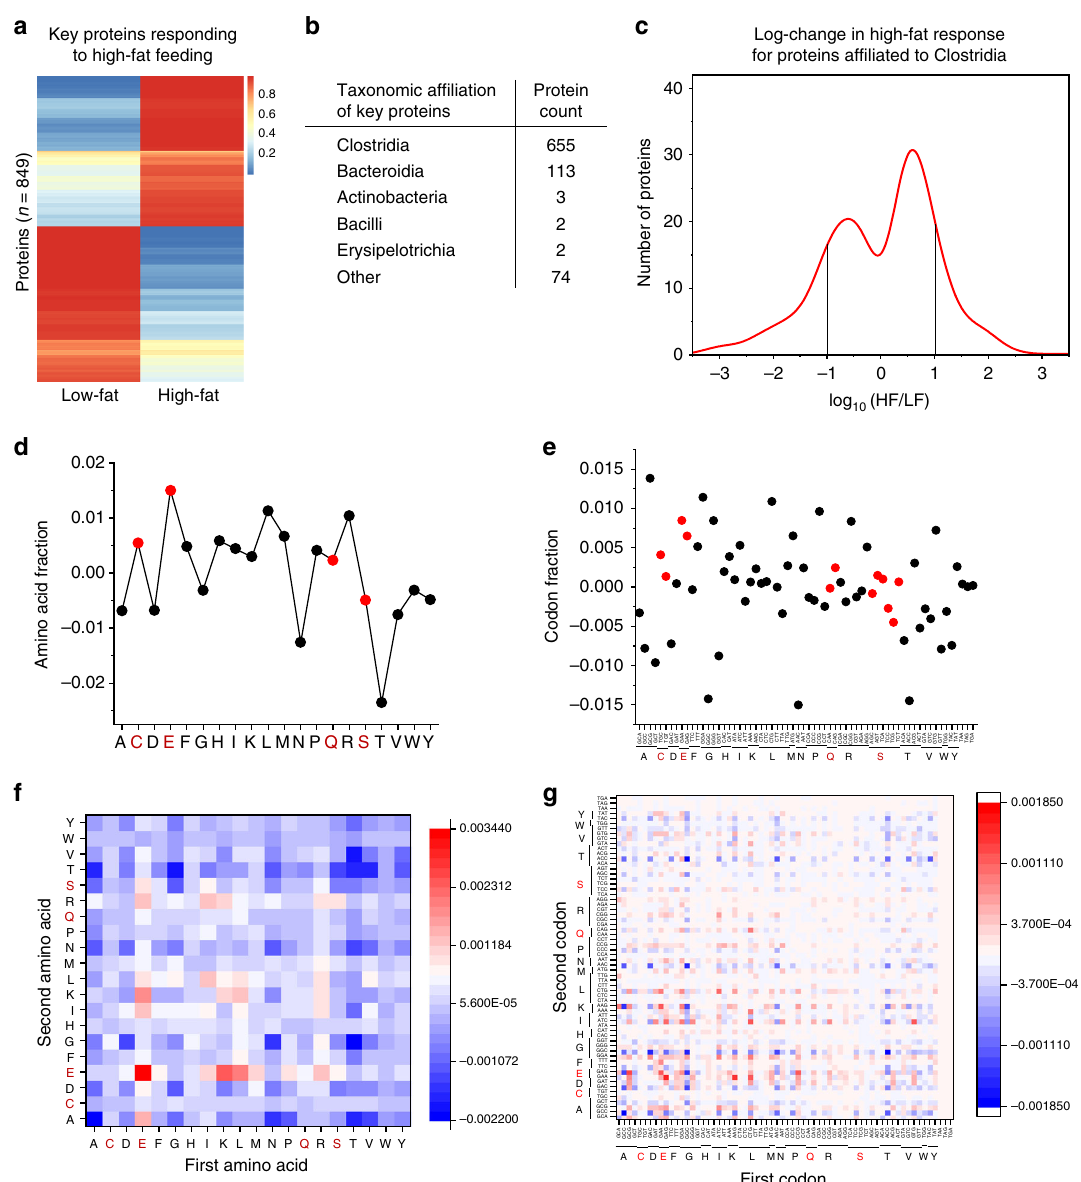
Fig. 7 Analysis of differential protein expression and tRNA modi fi cation. Proteomics data from HF- and LF-fed mice were from reference 36 . a Average differential expression of 849 proteins between HF- and LF-fed mouse gut microbiome from day 43 mice that most mimics the experimental condition of our tRNA-seq experiment. b BLASTp protein sequence analysis shows that most of these proteins are from class Clostridia. c Quantitative difference between the clostridia proteins from day 43 mice. Lines show the boundaries of the proteins used for downstream analysis that are highly enriched (log >1, 88 proteins) or depleted (log< − 1, 105 proteins) in HF over LF samples. The difference in amino acid ( d ) or codon content ( e ) determined by subtracting the compositions of HF over-expressed proteins minus the HF under-expressed proteins. The amino acids or codons for which their decoding tRNAs were found to contain m 1 A modi fi cations are in red: Cys, Glu, Gln, Ser. The difference in amino acid pair ( f ) and codon pair content ( g ) determined by subtracting the pair compositions of HF over-expressed proteins minus the HF under-expressed proteins. The fi rst amino acid represents the N-terminal residue and the fi rst codon represents the 5 ’